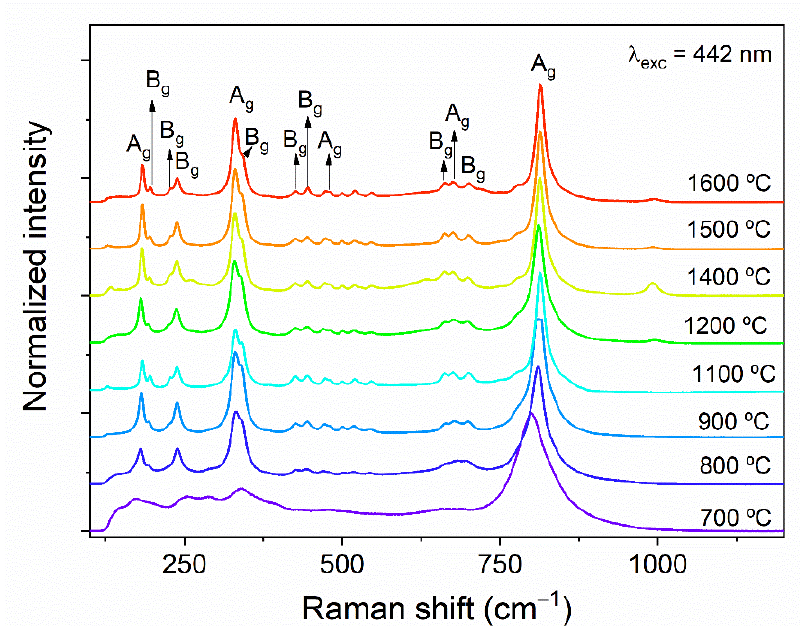
Figure 7. Raman spectra of the erbium niobate samples heat-treated at different temperatures. The spectra were acquired with the 442 nm line of a He-Cd laser in the backscattering configuration. Assignments according to [18].